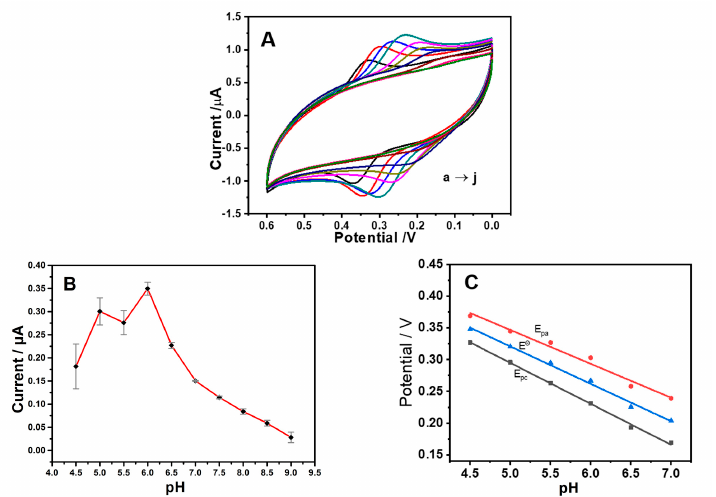
Figure 4. ( A ) CVs of 0.5 μ M of LU on UiO-66/ErGO/GCE in various pH (a to j: 4.5 to 9.0) of supporting electrolyte solutions (scan rate of 0.05 V s -1 ). ( B ) Effect of pH on the Ipa of LU. ( C ) Effect of pH on the oxidation peak potential (Epa) of LU.